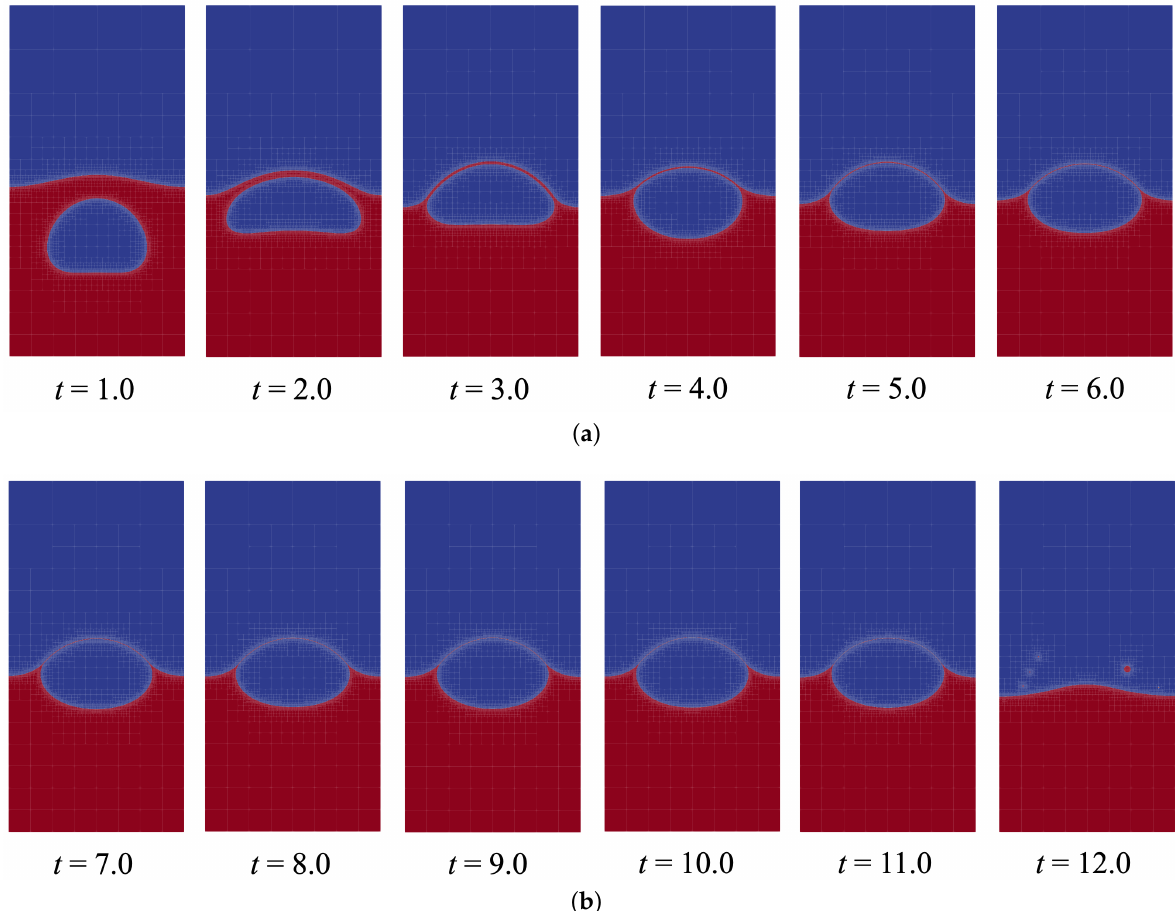
Figure 15. Volume fraction profile for the bubble rising to an interface starting from the contaminated state and forming liquid film in surfactant solution with a Langmuir number of La = 15, from t = 1.0 to t = 12.0. The region presented in red contains heavy fluid and the region presented in blue contains light fluid. AMR leaves are shown as light gray lines. ( a ) Volume fraction profile for the bubble rising to an interface starting from the contaminated state and forming a liquid film in surfactant solution, La = 15, from t = 1.0 to t = 6.0. ( b ) Volume fraction profile for the bubble rising to an interface starting from the contaminated state and forming liquid film in surfactant solution, La = 15, from t = 7.0 to t =